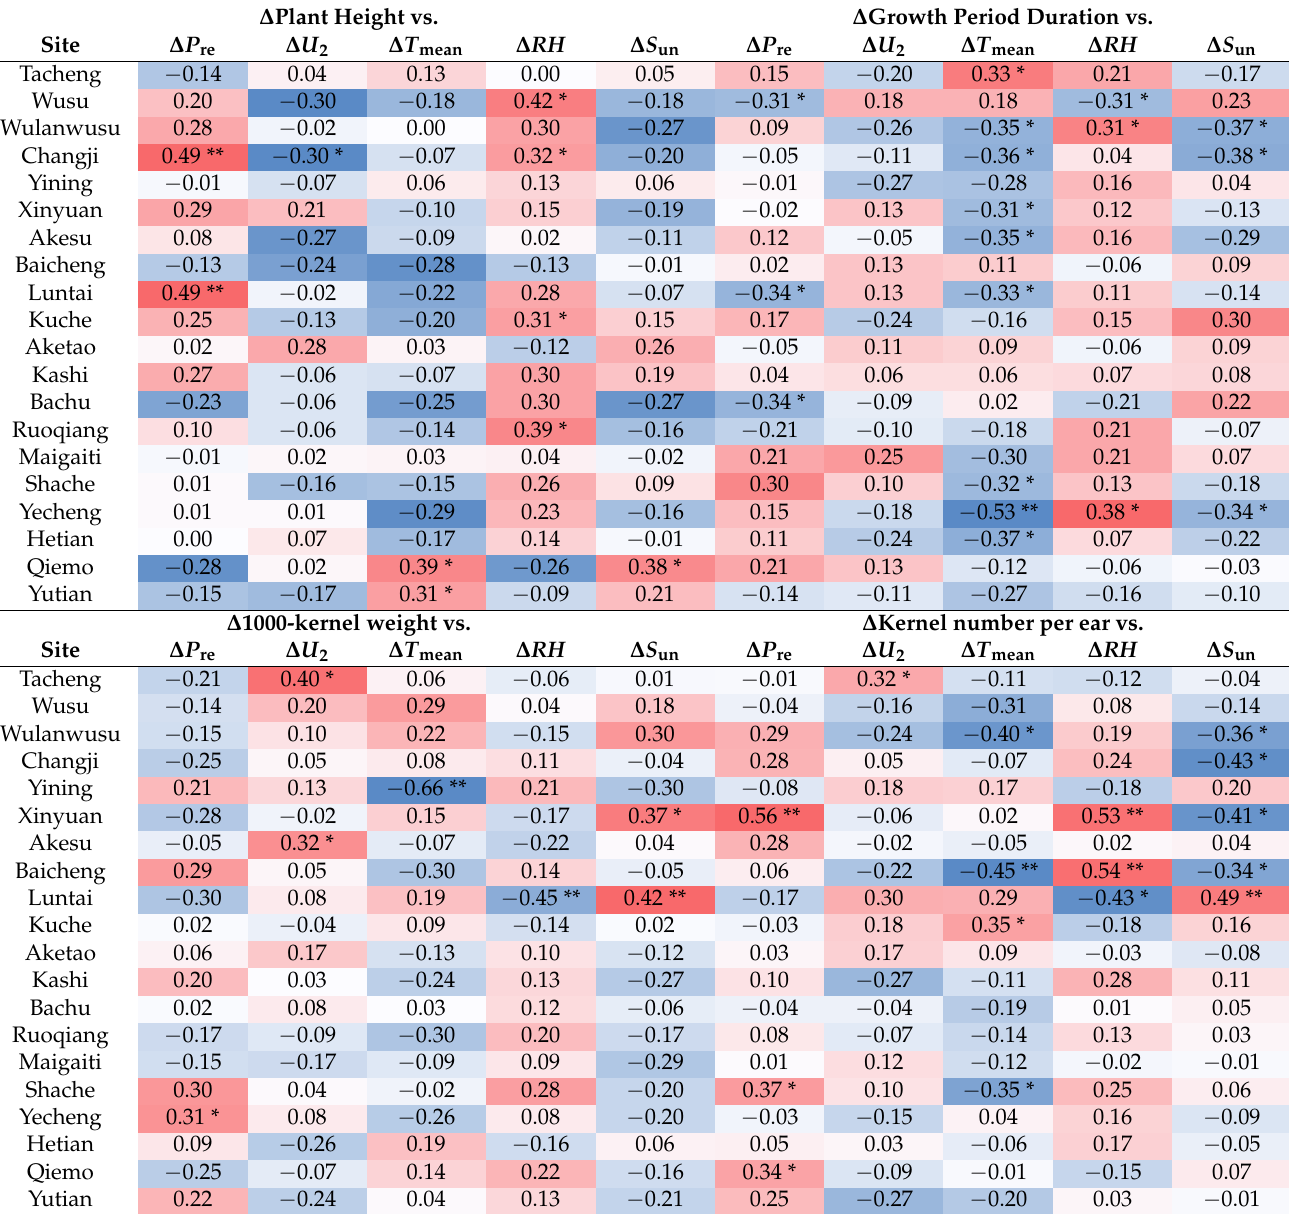
Table 2. The Pearson correlation coefficients between first differences of four growth indices (plant height, growth period duration, 1000-kernel weight and kernel number per ear) and climatic variables over 1981–2017 at the 20 sites in Xinjiang, China. Red and blue grids represent positive and negative correlations, respectively. ∆ Plant Height vs. ∆ Growth Period Duration